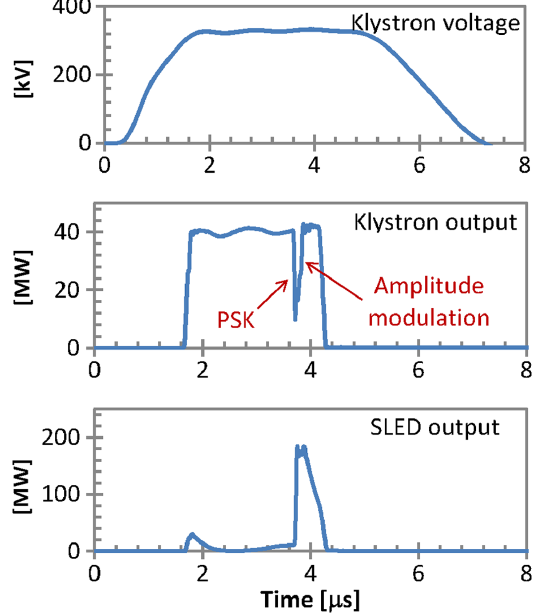
FIG. 9. Typical waveforms of the klystron cathode voltage, klystron output power and SLED output power for a 38 MV = m structure gradient. The phase switch keying (PSK) and the amplitude modulation applied by the LLRF system are also shown in the plot (see